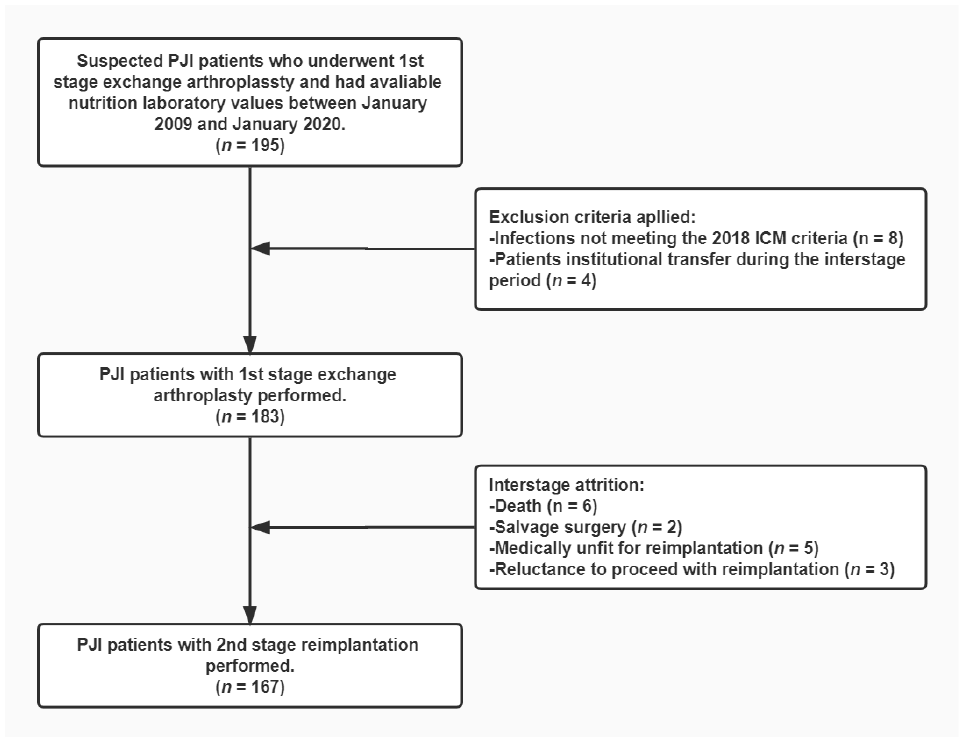
Figure 1. This flowchart demonstrates how patients were identified for inclusion in the final cohort. PJI, periprosthetic joint infection; ICM, International Consensus Meeting. PJI, periprosthetic joint infection; ICM, International Consensus